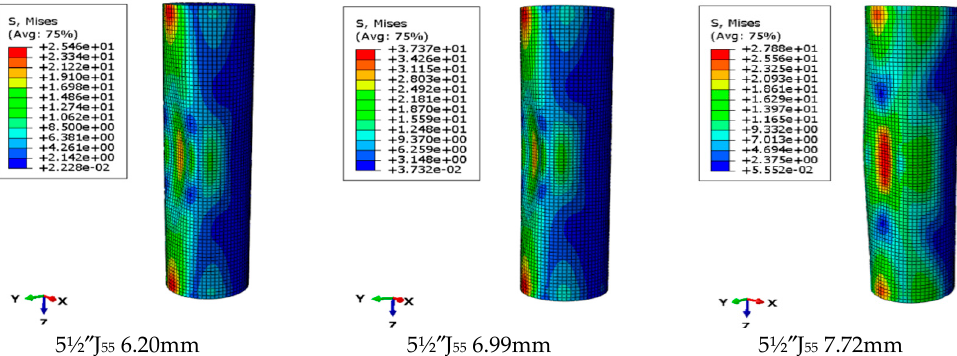
Figure 8. Calculation results of deformation on different wall thicknesses of 5½ ″ J55-type casing.